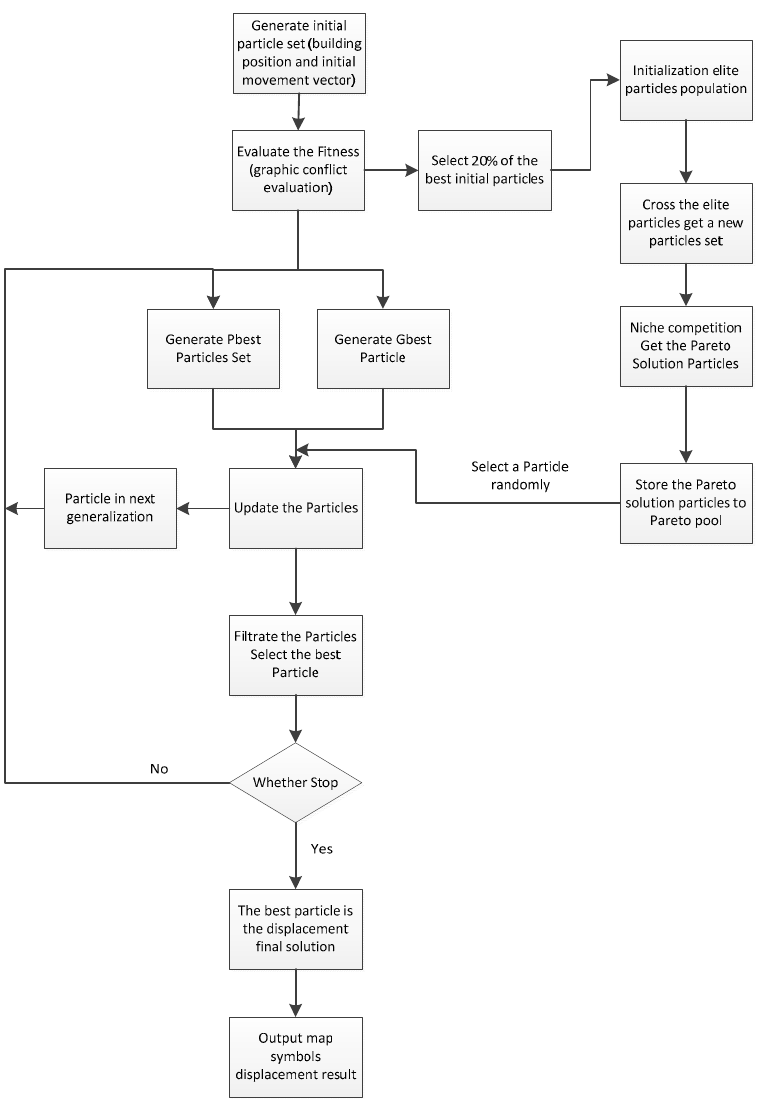
Figure 2. The flowchart of the improved PSO displacement algorithm.